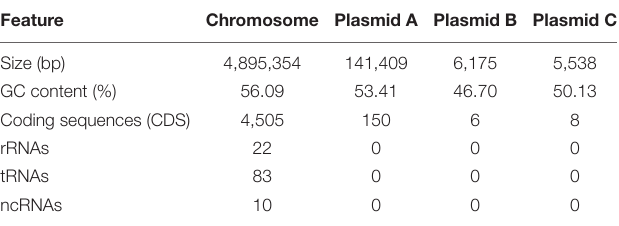
TABLE 1 | General genome features of strain Pa82. Feature